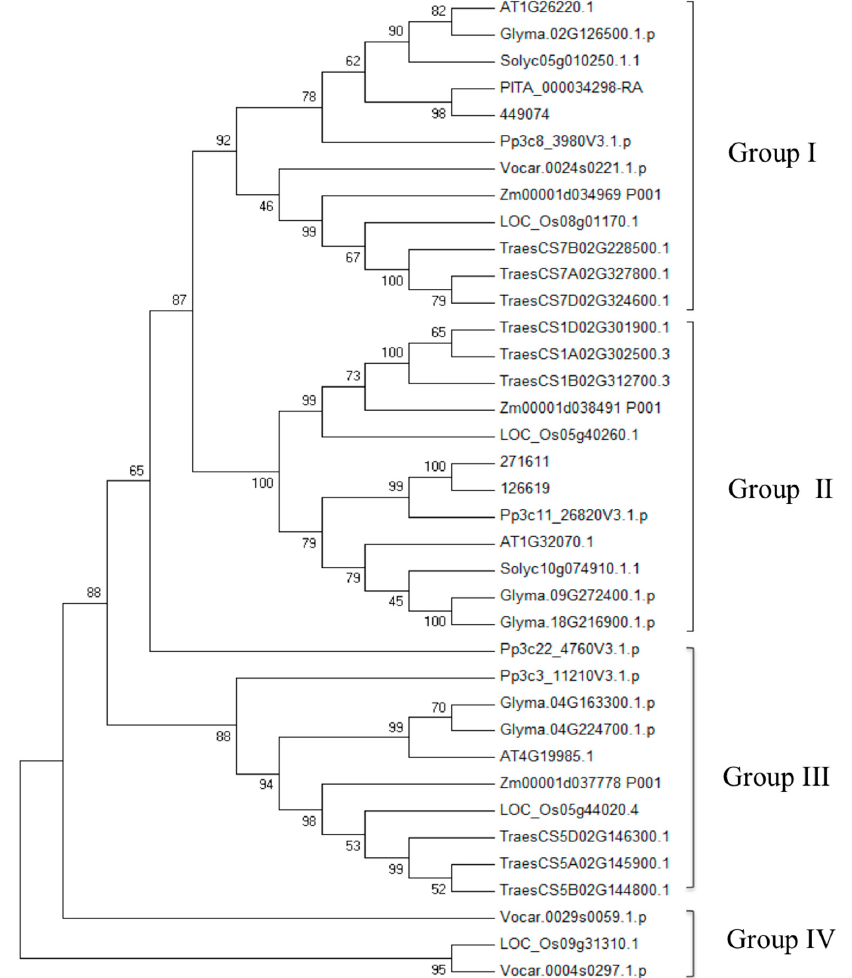
Figure 1. Phylogenetic relationship of the serotonin N-acetyltransferase ( SNAT ) genes from 10 plant species. The candidate SNAT genes involved in the phylogenetic tree include the dicots ( Arabidopsis.thaliana (AT): AT1G26220.1, AT1G32070.1, and AT4G19985.1; Solanum lycopersicum (Solyc): Solyc05g010250.1.1, and Solyc10g074910.1.1; Glyma max (Glyma): Glyma.02G126500.1.p,